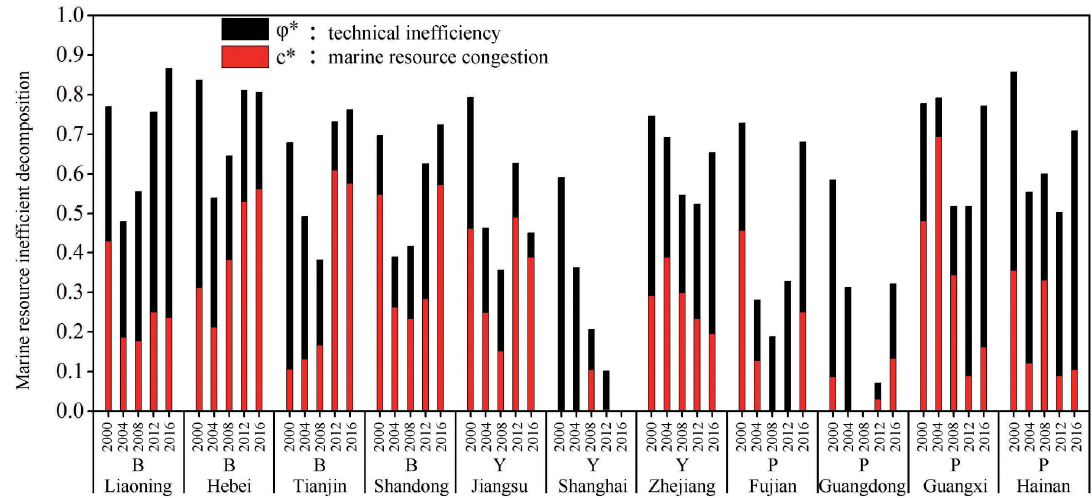
Fig 4. Marine resource inefficiency decomposition for 11 coastal provinces and